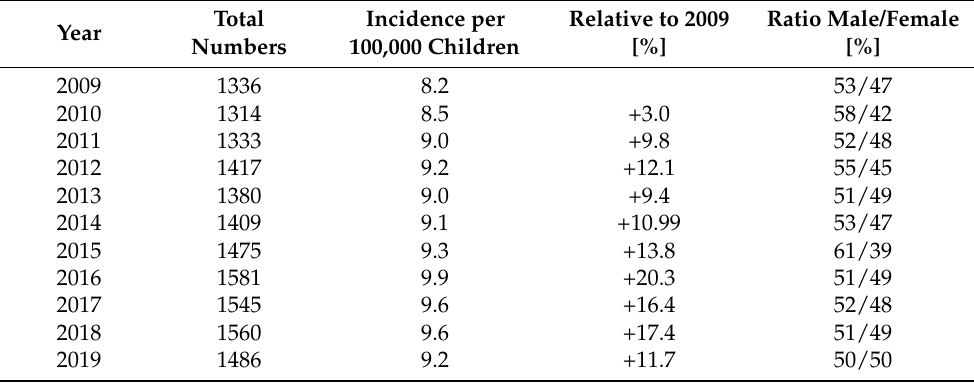
Table 1. Pediatric osteomyelitis incidence changes between 2009 and